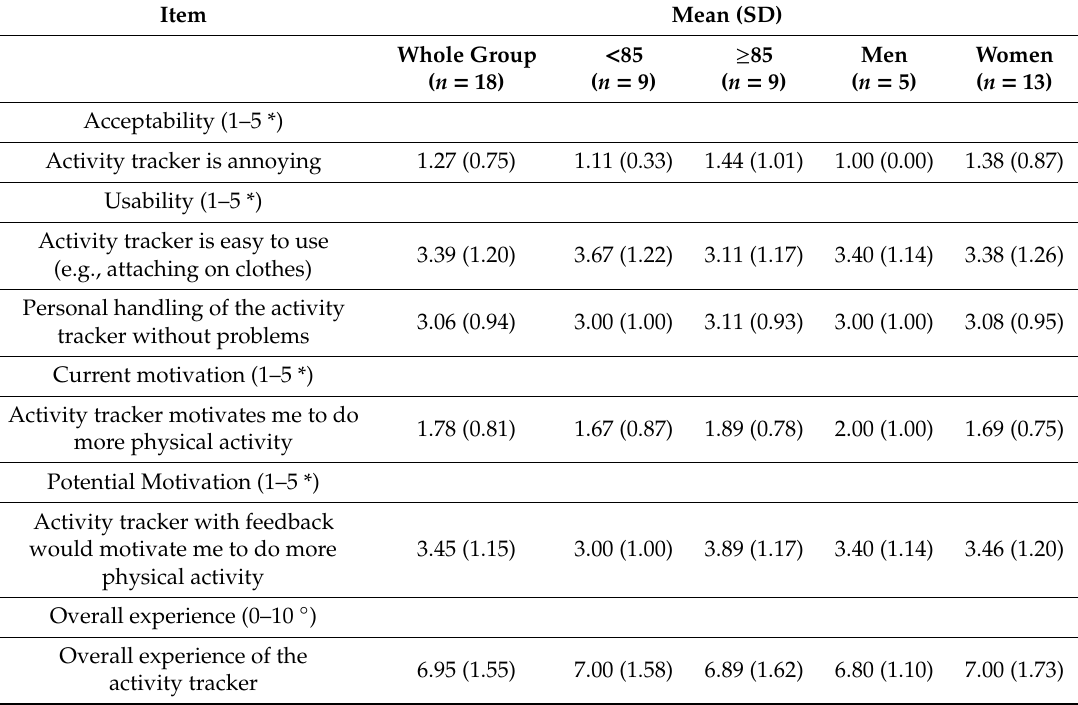
Table 6. Acceptability, usability, motivational capability of Fitbit Zip—Mean Scores.